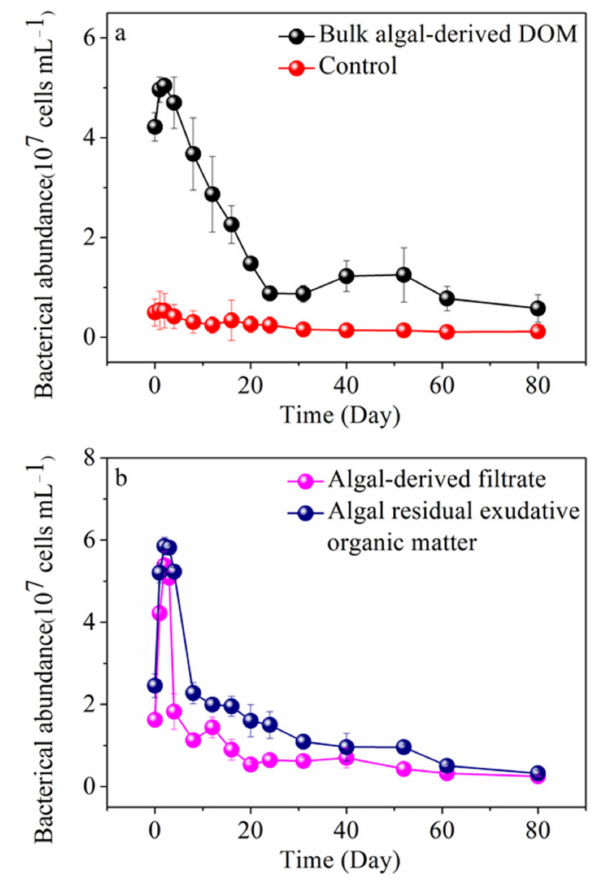
Figure 10. Dynamic changes in free-living bacterial abundance during 80-d degradation processes of ( a ) bulk algal-derived dissolved organic matter (DOM) group and in natural lake water group (as control), and ( b ) algal-derived filtrate group and algal residual exudative organic matter